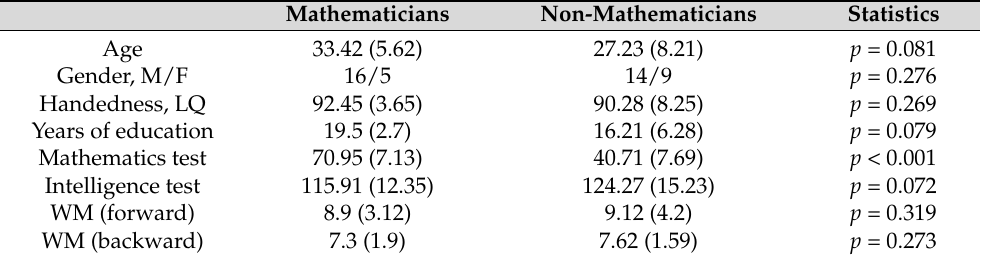
Table 1. Demographic and cognitive profiles of the mathematicians and